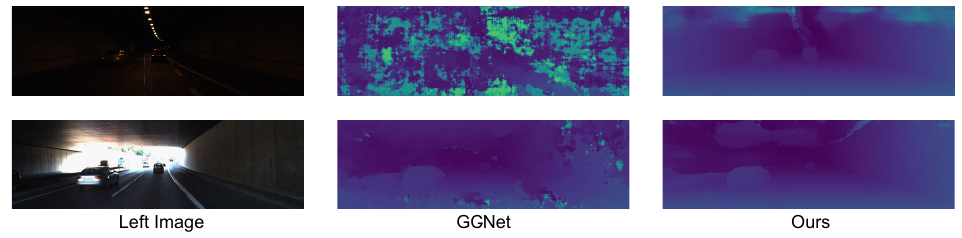
Figure 6. Results at dim and noise regions. The top one is in the training set, while the bottom one is in the testing